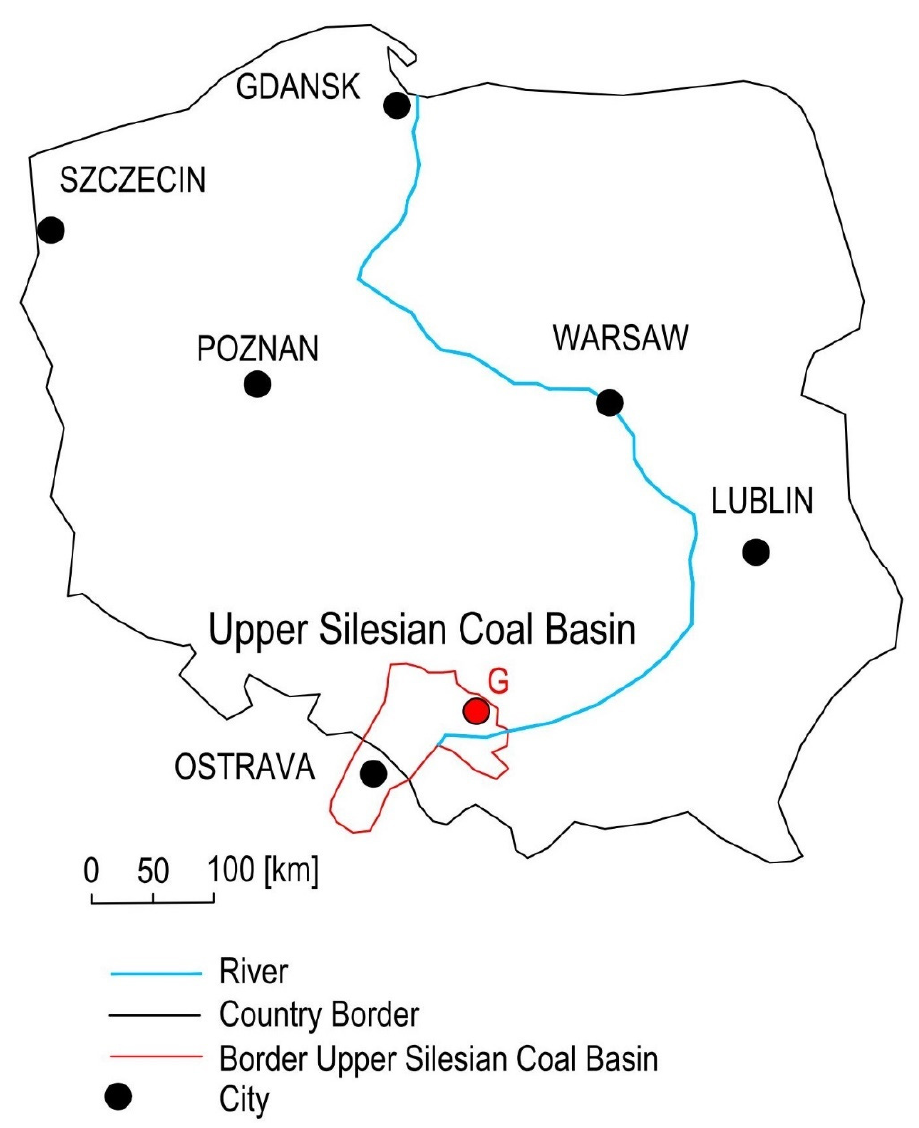
Figure 6. Location of the research area on the map of Poland.